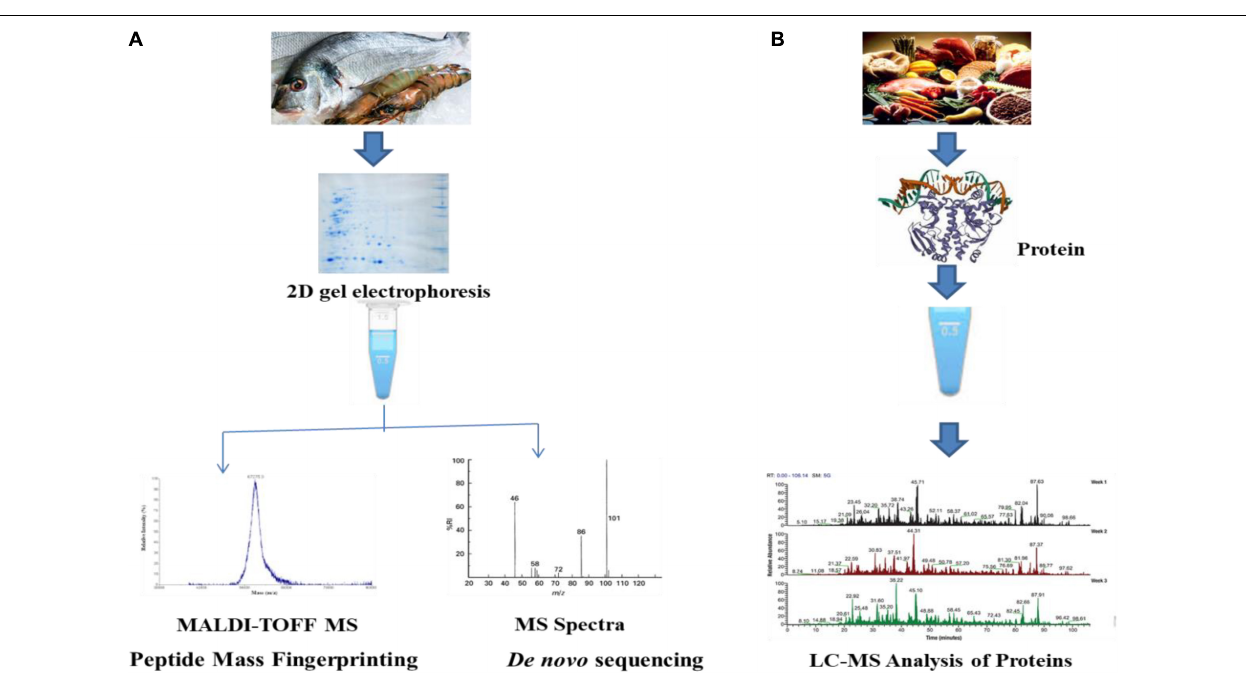
FIGURE 1 | Proteomic analysis of the food associated microorganisms.